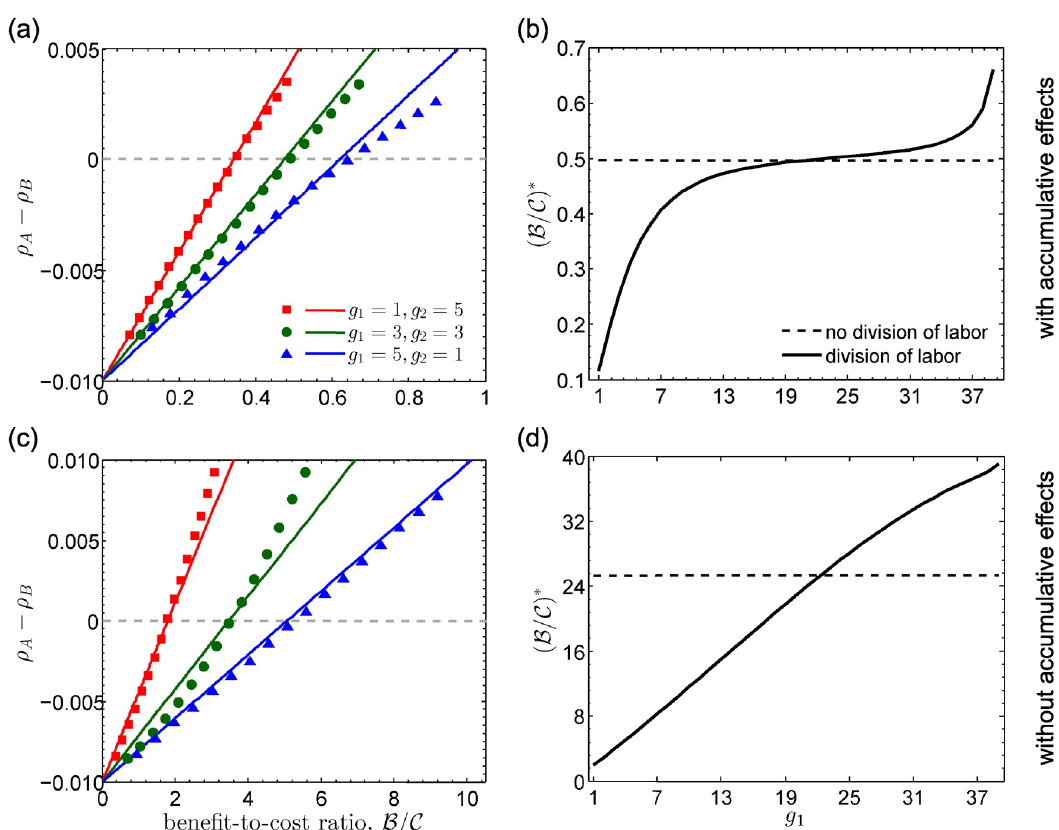
Fig 4. Difference in fixation probability ρ A - ρ B and critical benefit-to-cost ratio ð B = C Þ � for ρ A > ρ B as a function of g 1 . (ab) Division of labor with accumulative effects of payoffs (the increasing number of cooperators leads to the increasing productivity). (cd) Division of labor without accumulative effects of payoffs (the productivity remains unchanged as the increasing number of cooperators). In (a) and (c), we consider n = 2 and different parameters of g 1 and g 2 . Dots presents simulation data (see S1 File, Section 6 for simulation details) and lines are analytical predictions. ρ A − ρ B is analytically predicted by the product of the left side of Eq (1) and the selection intensity ω . In (b) and (d), dash lines correspond to ð B = C Þ � for the case with no division of labor and solid lines ð B = C Þ � for the case with division of labor, where g 2 = 40 − g 1